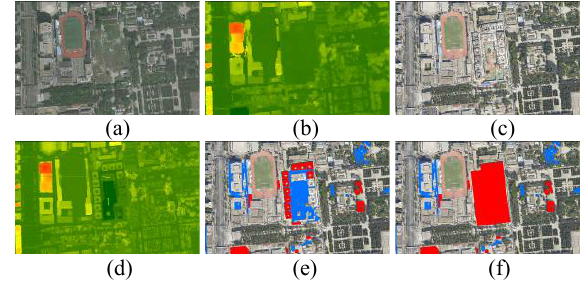
Figure 8. DSM difference and filter results. (a) TDOM of 2015, (b) DSM of 2015, (c) TDOM of 2017, (d) DSM of 2017, (e) automatically extracted change patches, (f) manually extracted